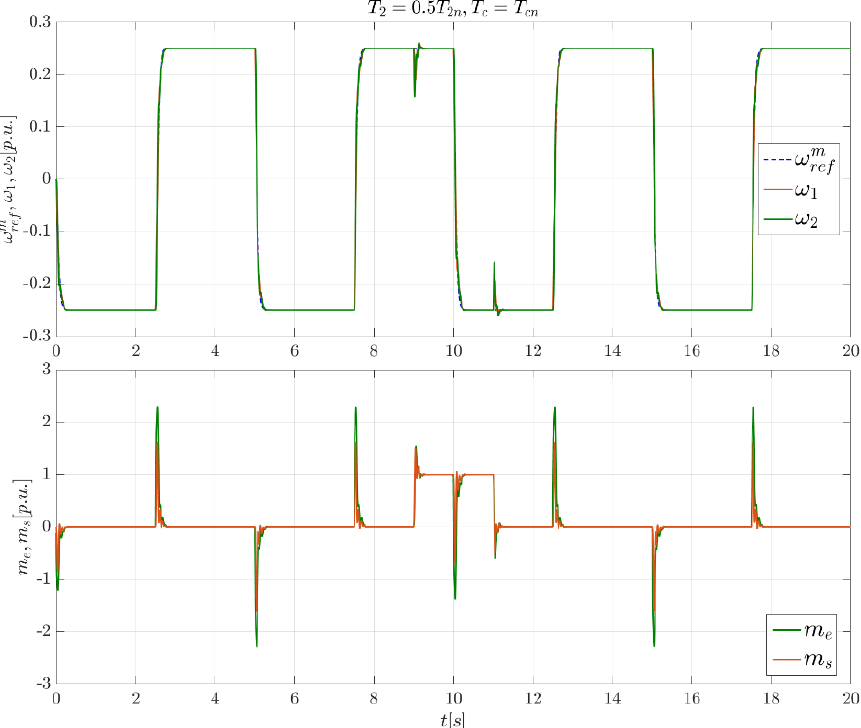
Figure 10. Speeds ( ω ref , ω 1 , and ω 2 ) and torques ( m e and m s )—transients for the decreased load time constant ( T 2 = 0.5 T 2 n ).